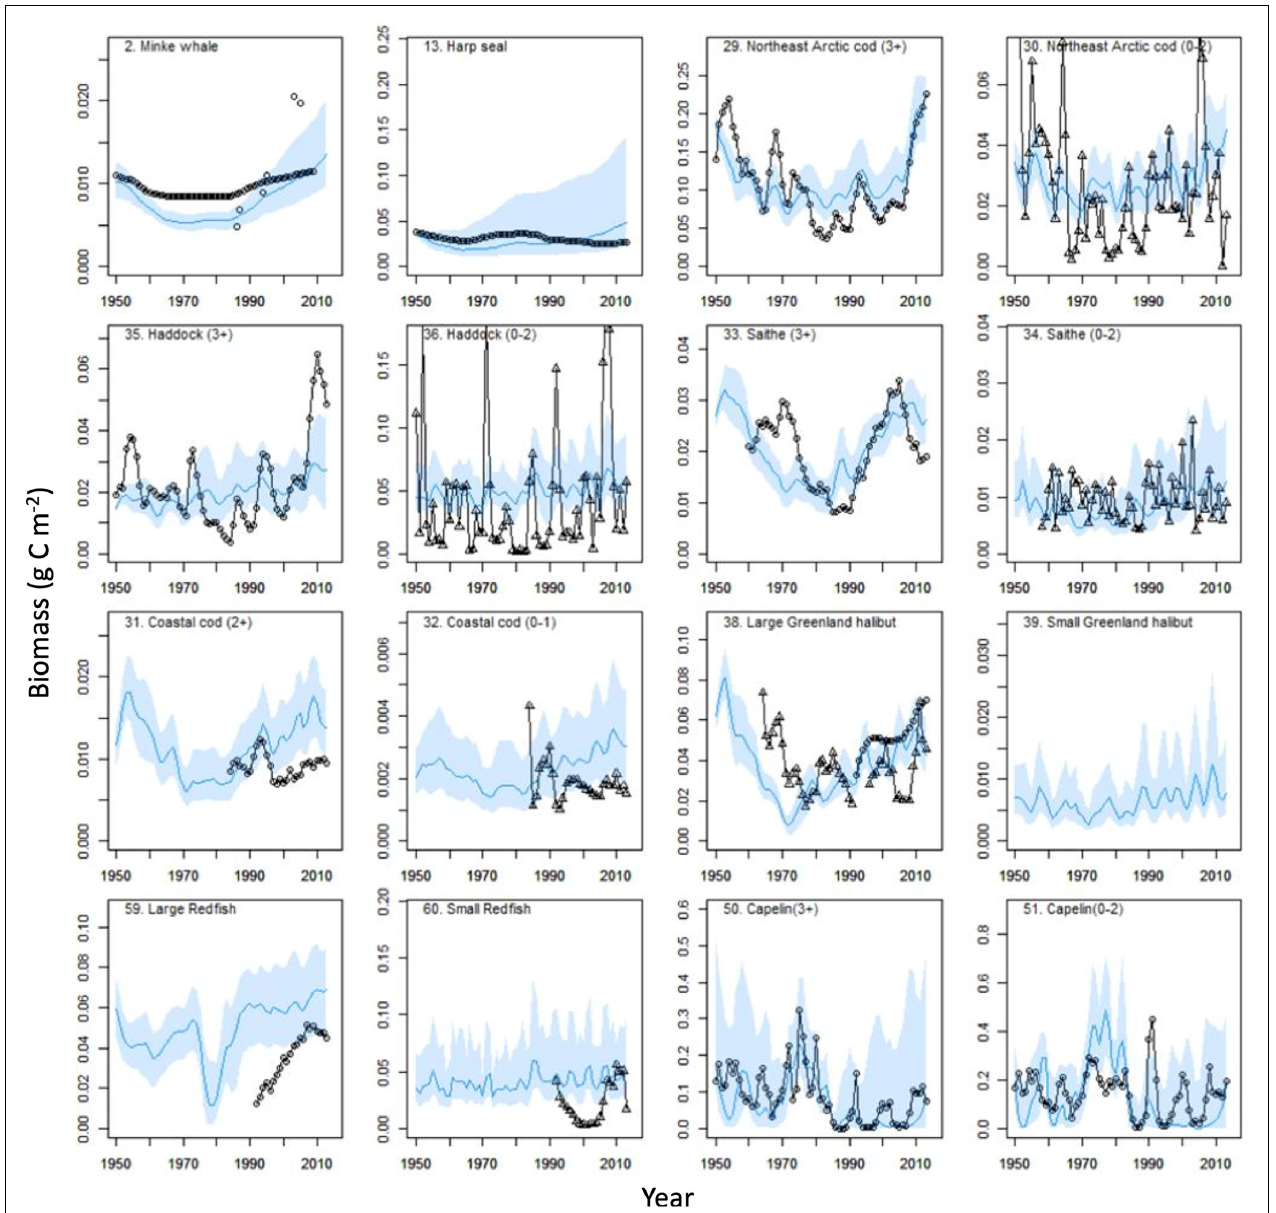
FIGURE 2 | Biomass (g C m − 2 ) changes for functional groups during 1950–2013 for modeled (model M10, continuous blue line) and observed (circles, absolute biomasses; triangles, relative biomasses). Blue line shows mean value and blue bands shows 2.5 and 97.5 percentiles from 200 Monte Carlo